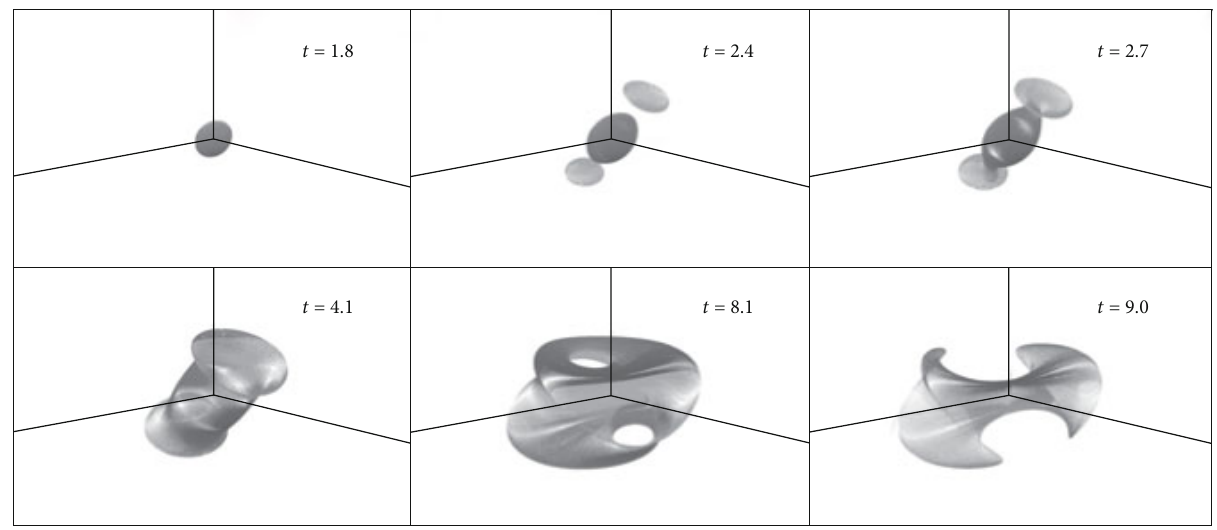
Figure 11: Three-dimensional wave fronts of null geodesics emitted by an observer at the origin at six successive times. After an initial expansion, two distinct portions of the wave front appear separated from the main front at t = 2 : 4 . These portions of the wave front rejoin the main branch shortly after, leaving two outer cusp ridges as the wave front singularities. An opening forms before t = 8 : 1 which leads to a pinching o ff of the wave front, which in Figure 4 was the vanishing portion of the wave front in the plane.